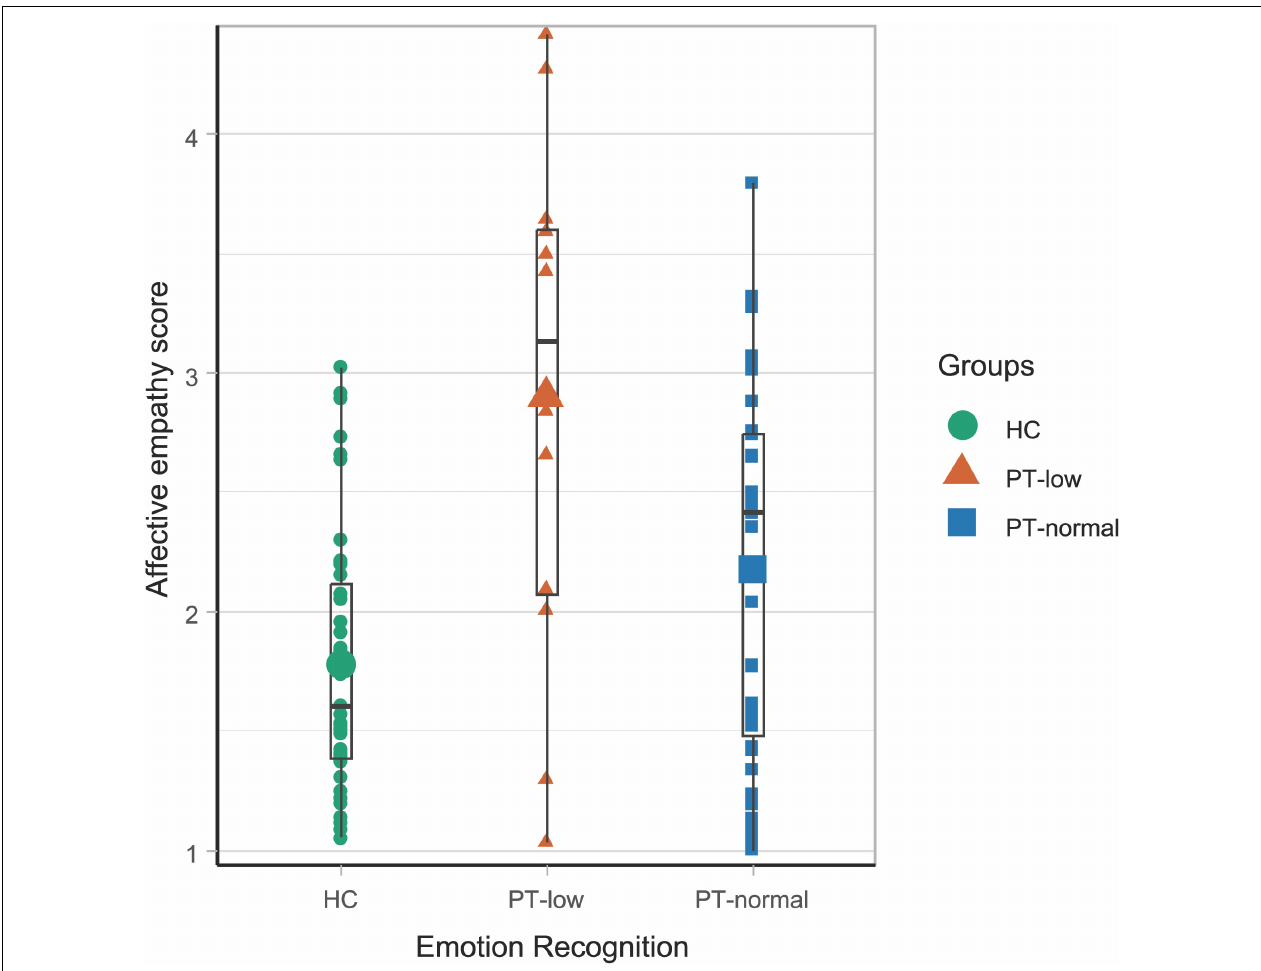
FIGURE 3 | Performance on affective empathy task in controls and in the two patient groups (PT-low and PT-normal). The boxplot shows range, first and third quartile and median (black horizontal line). The larger symbols show the means; The green circles represent the controls (mean ± SD = 1.77 ± 0.55), the orange triangles represent patients with scores lower than controls (PT-low: mean ± SD = 2.90 ± 1.11) and the blue squares represent patients with scores in the same range as controls (PT-normal: mean ± SD = 2.2 ±